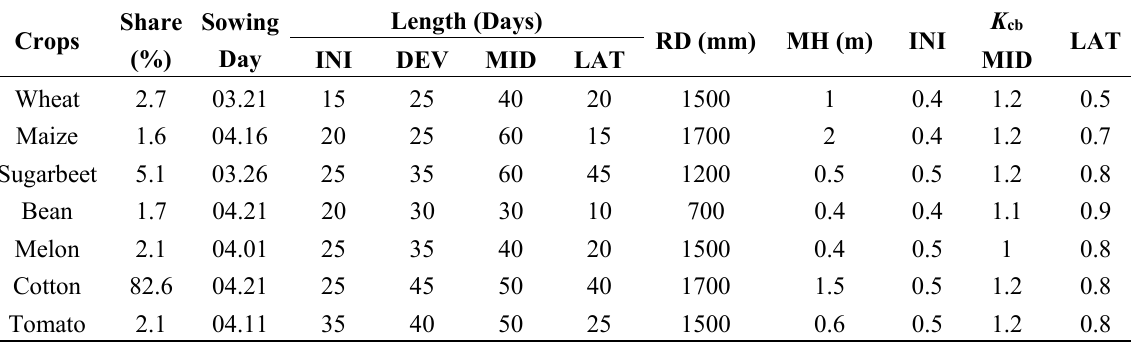
Table 2. Crop factors and growth stages in study area. Data on the share (%) and sowing day were collected from the CAS. Length (days), RD (mm), MH (m), and K cb values were based on a FAO publication [23], with some adjustment based on field surveys of the study